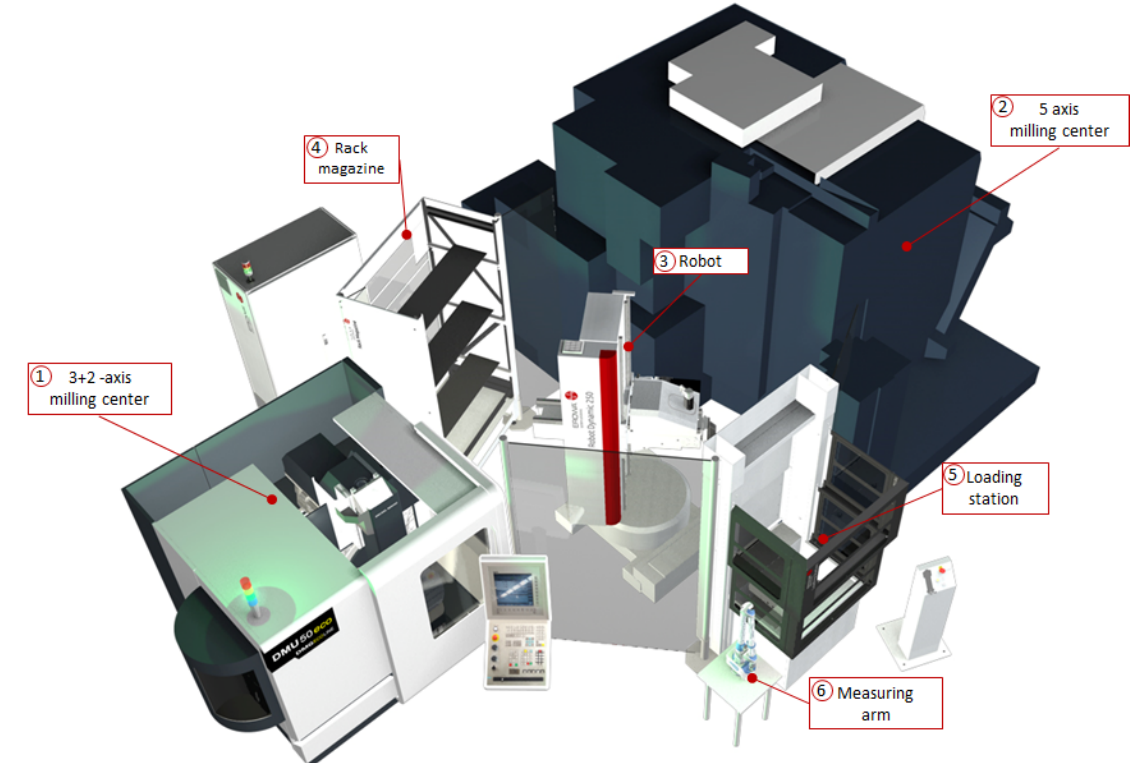
Figure 4. 3D layout of the RAMEM post-processing pilot cell overview. (1) 3 + 2-axis Milling centre (DMU 50 ECO), (2) 5-axis Milling centre (Makino DS500), (3) Robot (EROWA ERD 250 XT), (4) Rack magazine (EROWA), (5) Loading station (EROWA), (6) Measuring arm (FARO